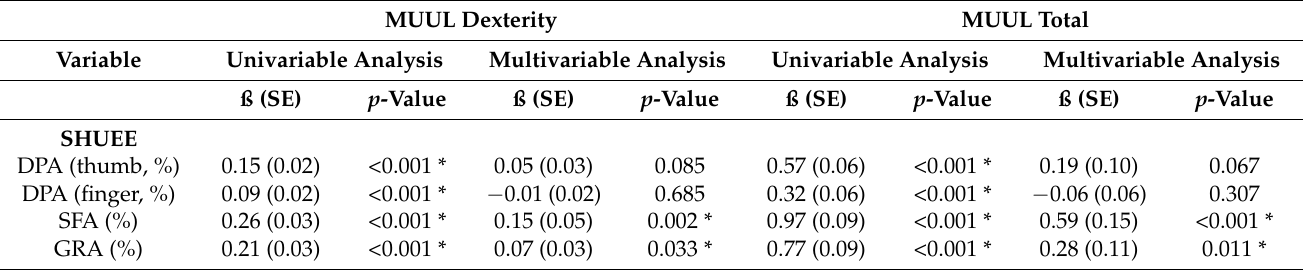
Table 3. Regression analysis of SHUEE subscales associated with